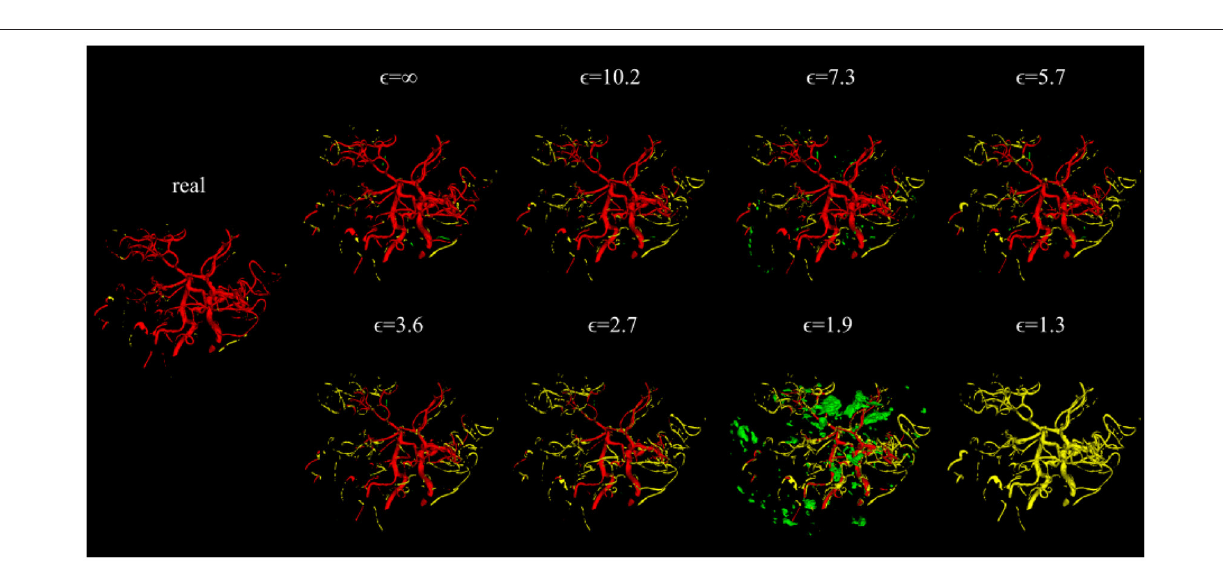
FIGURE 4 | Error maps of one example test patient for U-Nets trained on either real image-label pairs or generated image-labels with different values of ǫ . True positives are shown in red, false positives in green, and false negatives in yellow. For lower ǫ , more errors